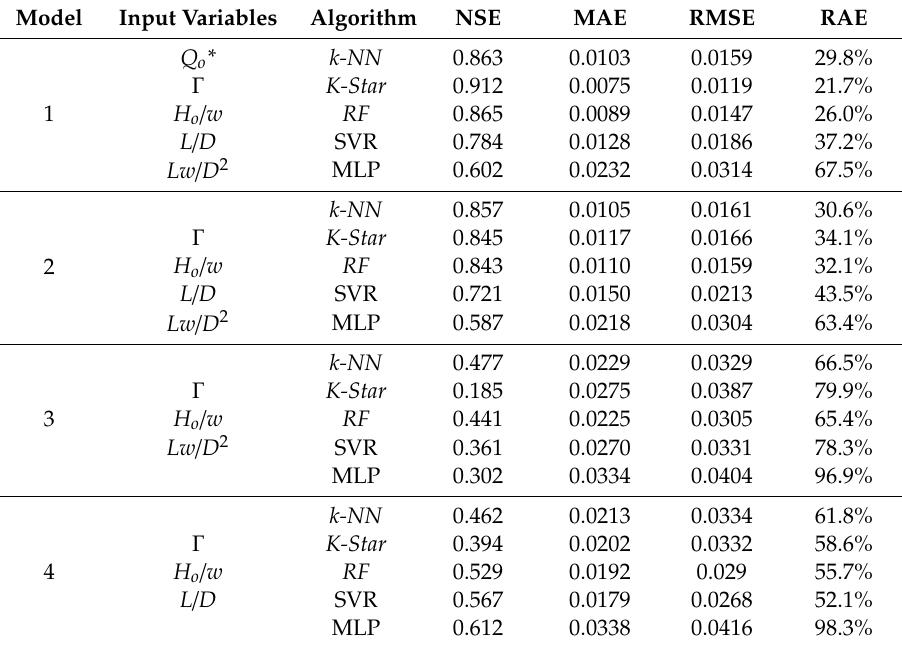
Table 3. Summary of